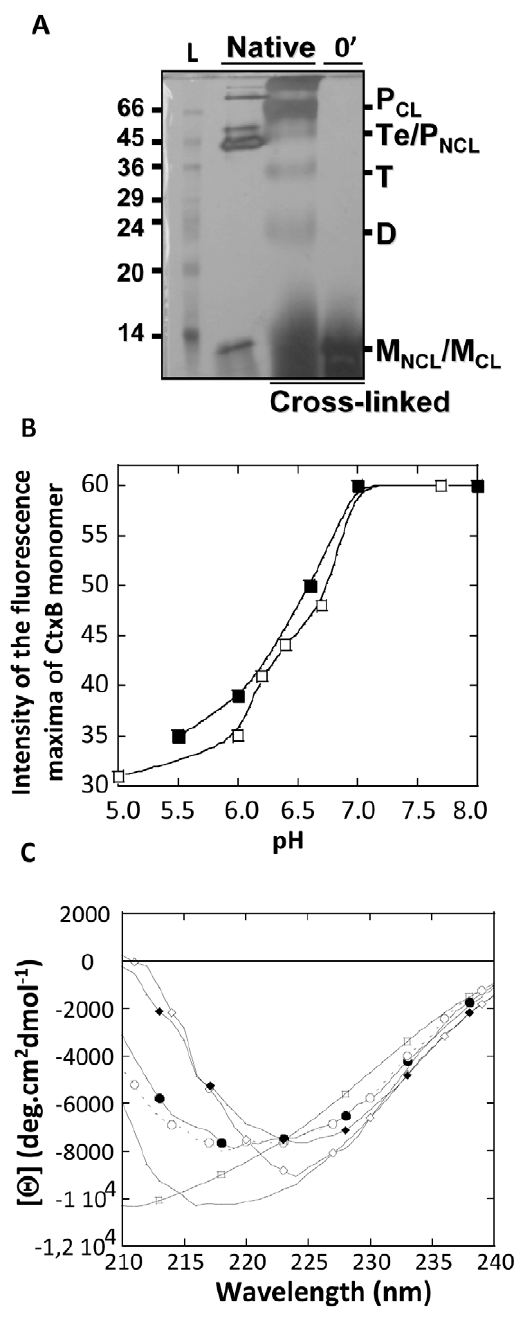
Figure 3. Conformational changes in the structure of the CtxB monomer as function of pH. CtxB 5 was treated for 15 min at pH 1.0 and subsequently diluted to a final concentration of 8.6 m M, or otherwise specified, in McIlVaine buffers at indicated pH A. CtxB monomeric state. After acidification and just after dilution in McIlVaine buffer at pH 7.0, CtxB was cross-linked (0 9 ) with glutaralde- hyde for 2 min prior mixing with 4 6 sample buffer and subsequent analysis by SDS-PAGE. The same treatment was performed on native CtxB 5 , to indicate the position of cross-linked CtxB monomer (M CL ), dimer (D), trimer (T) tetramer (Te) and pentamer (P CL ) ( 23 ). Native, not cross-linked CtxB 5 , was also loaded on the gel to indicate the position of the native pentamer without cross-linking (P NCL ). Some of the native CtxB 5 , not cross-linked, did not resist the SDS treatment after boiling and dissociated into monomer, indicating the apparent molecular weight of the non cross-linked monomer (M NCL ). L stands for